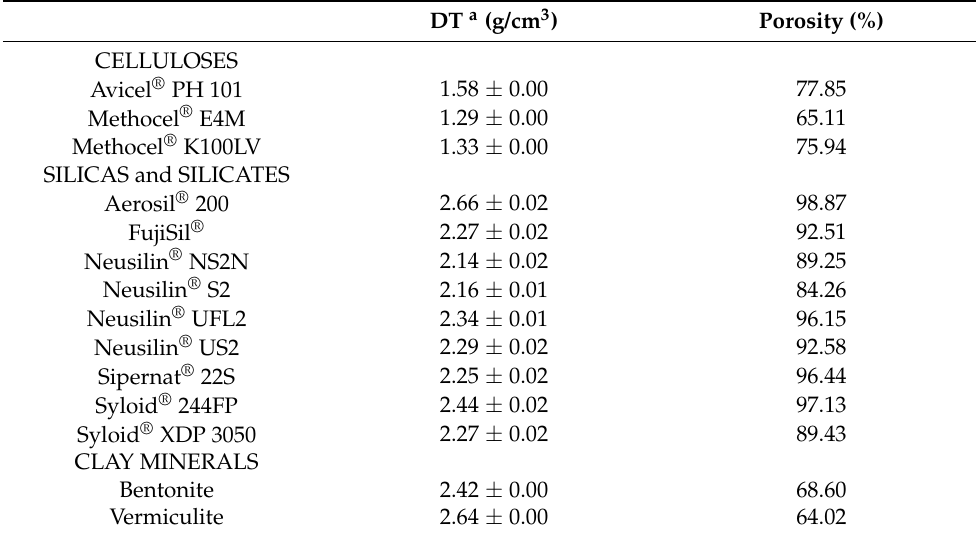
Table 3. True density and porosity of powder